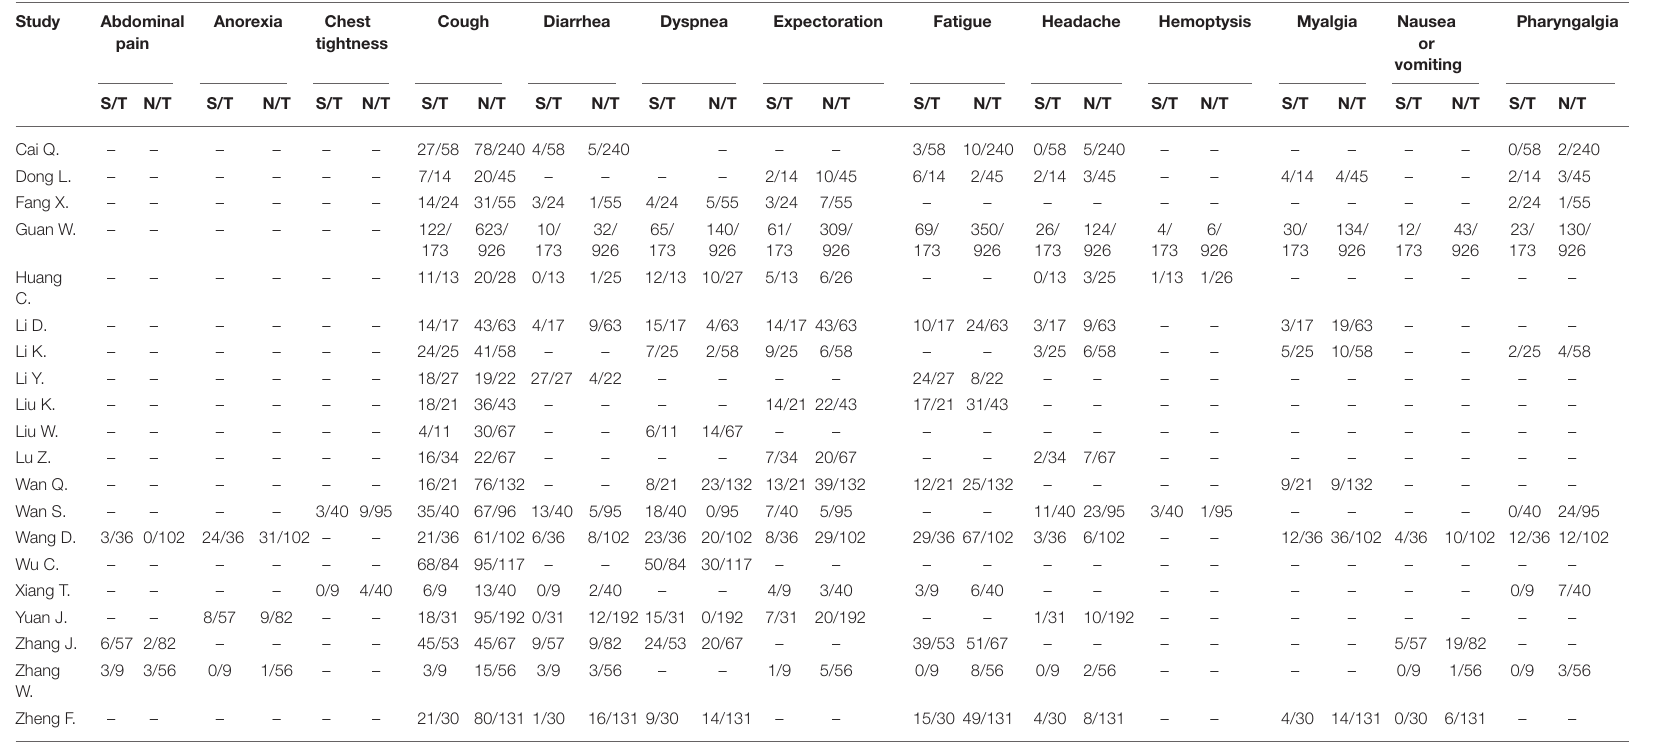
TABLE 2 | Clinical characteristics of the include studies on